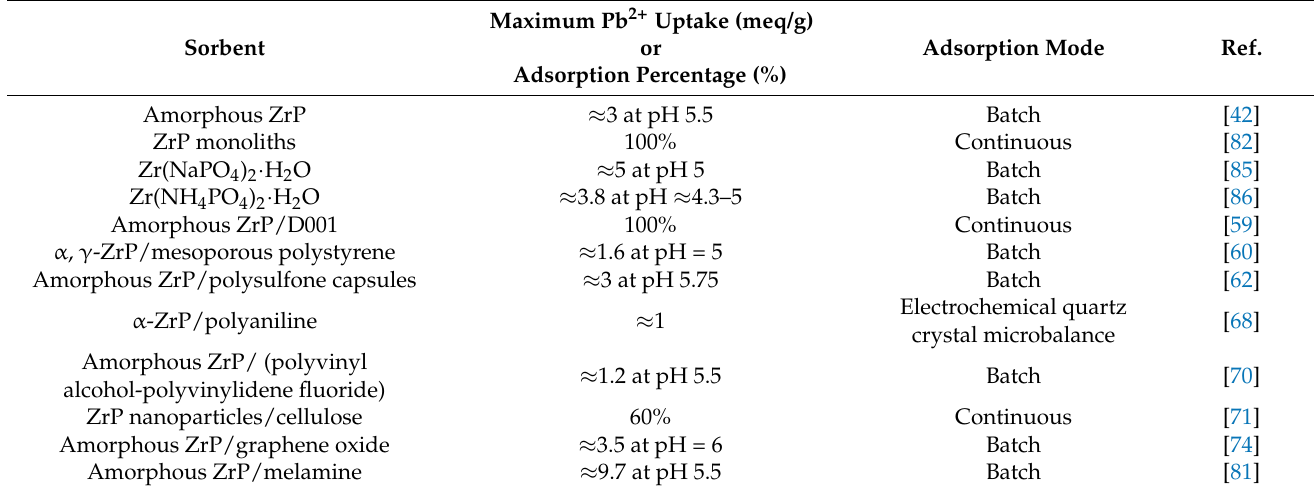
Table 2. Maximum Pb 2+ uptake, or adsorption percentage values, for ZrP-based sorbent materials.